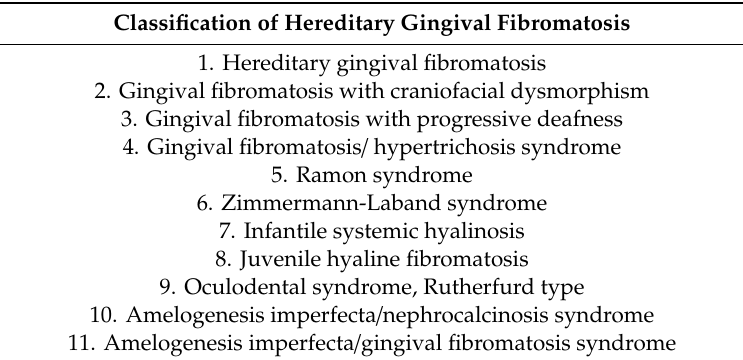
Table 1. Classification of hereditary gingival